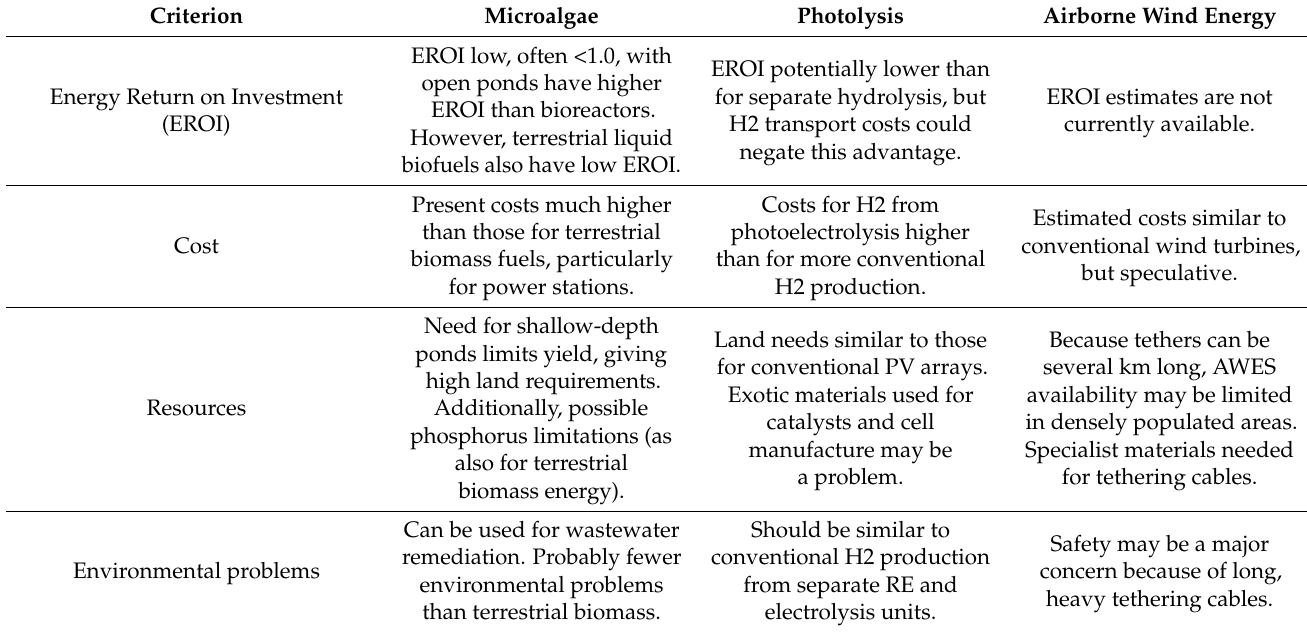
Table 1. Comparison of the three technologies against performance